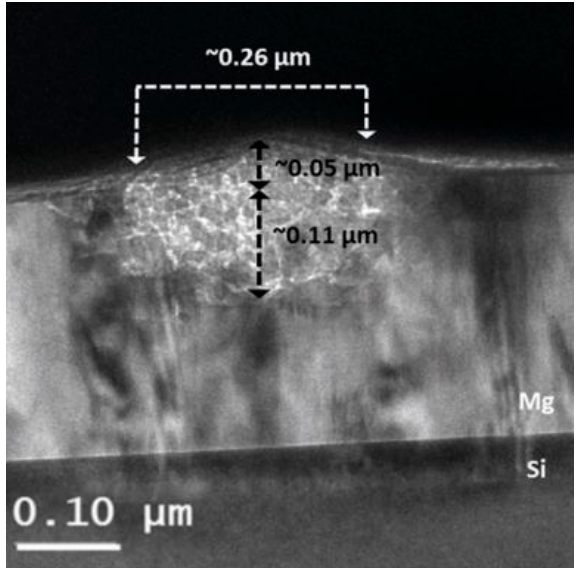
Figure 10. TEM observation of an MgH 2 nanodomain in an Mg film coated by a thin MgO layer. The domain, with depth ≈ 110 nm, lateral size ≈ 260 nm, and protrusion height ≈ 50 nm, forms below a Pd nanoparticle acting as a H nanoportal. Reprinted with permissions from [32] (copyright